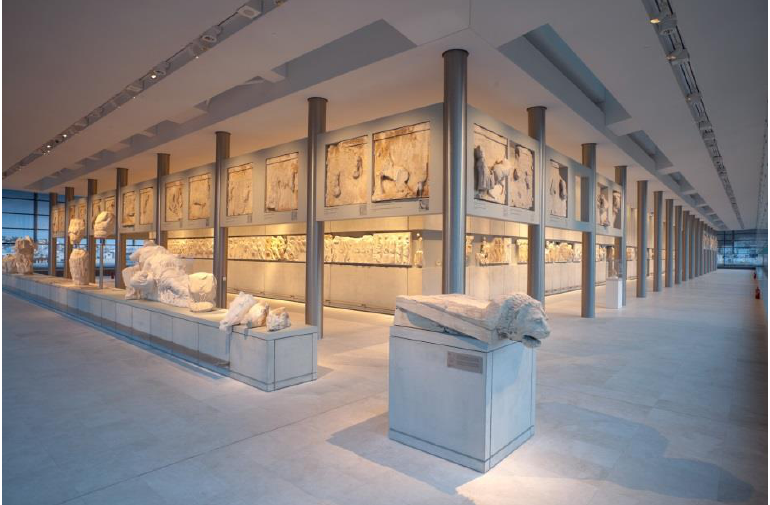
Figure 3. The north-east corner of the Parthenon Gallery in the New Acropolis Museum. The sculptures from the east pediment of the temple are to the left, while the metopes are displayed on tubular steel supports, with the frieze visible behind. Such a presentation partially replicates the original arrangement of the marbles on the Parthenon, although the sculptures of the pediment are positioned below, rather than above, the other two sets of marbles. Photograph: Nikos Danielidis. © Acropolis